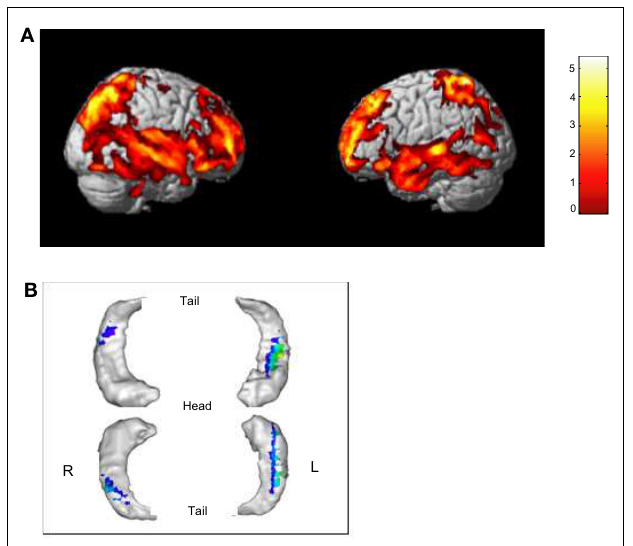
FIGURE 3 |Age-related effects on the brain . (A) Age-related changes concern fronto-temporal and posterior parietal regions bilaterally (uncorrected p < 0.001, K > 500). (B) A significant reduction was found in the hippocampus bilaterally, with a more extended region in the left hippocampus (uncorrected p < 0.01, K > 100).